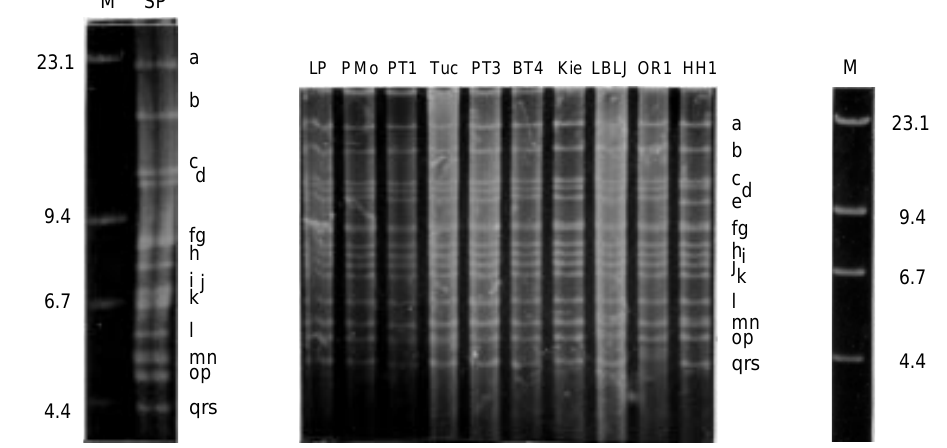
Figure 1 - Restriction fragment obtained with BamHI of 10 EHV- 1 strains isolated in Argentina from 1979 to 1991. M: Molecu- lar weight marker fragments ( l DNA HindIII digested) are re- ported as kilobases. Fragment nomenclature is shown on the right according to the report for the HH1 strain